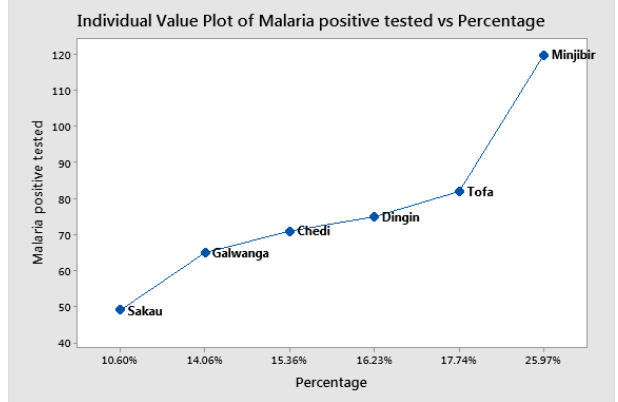
Figure 5: Figure 4 one-way ANOVA at 0.05 significant levels in 2018